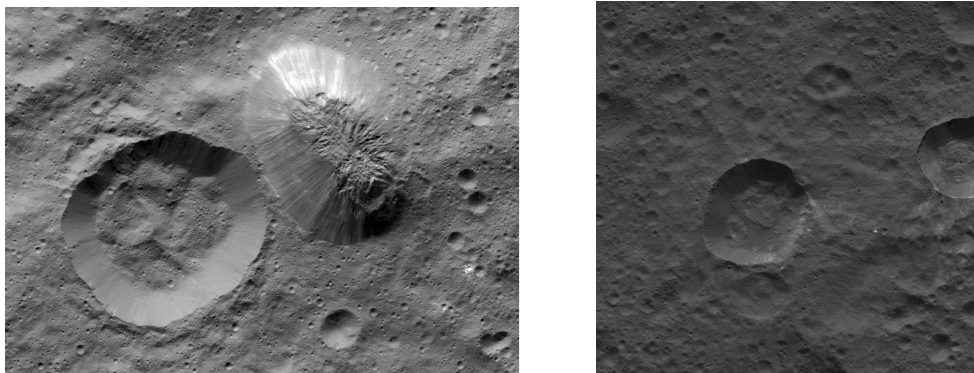
Figure 6. Left: Ahuna Mons and Crater B as seen in this mosaic of images from NASA’s Dawn spacecraft from 385 km (240 miles) above the surface, in December 2015. The resolution of the image is 35 m (120 feet) per pixel. (PIA20348). Right : Equator crater in Ceres used as control image for baseline computer vision comparison analysis with Ahuna Mons. (PIA20677). Images credit: NASA/JPL-Caltech/UCLA/MPS/DLR/IDA (130–140